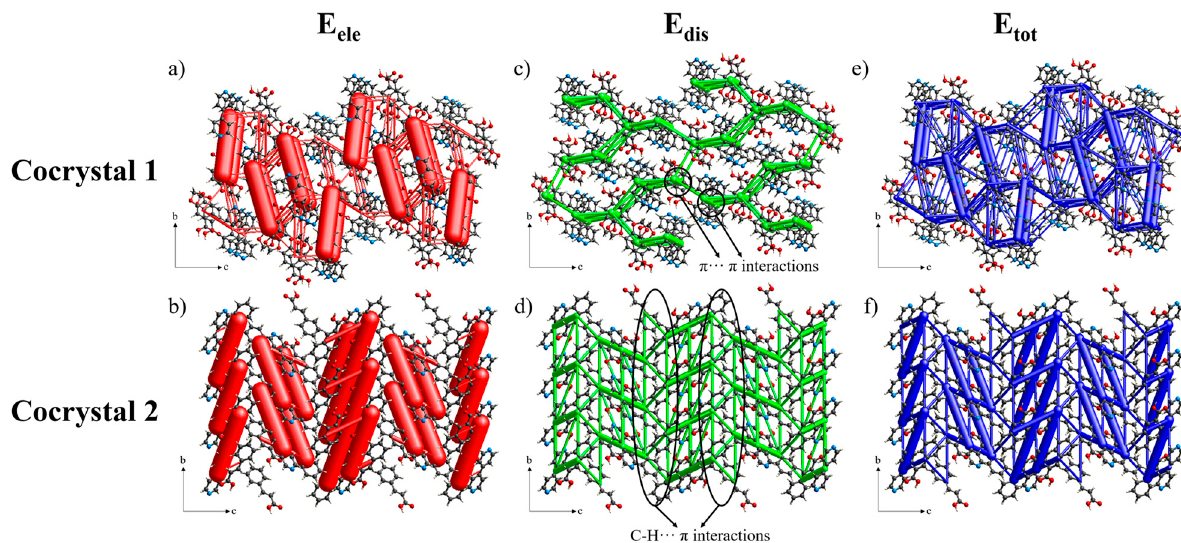
Figure 4. Energy frameworks (E ele , E dis, and E tot ) for cocrystals 1 and 2 . All the diagrams use the same energy cylinder scale factor of 150 and an energy cut-off of 6.00 KJ/mol within a 2 × 1 × 2 ( 1 ) and a 3 × 3 × 3 ( 2 ) unit cells. Electrostatic energy of ( a ) 1 and ( b ) 2 . Dispersion energy of ( c ) 1 and ( d ) 2 . Total energy of ( e ) 1 and ( f ) 2 .